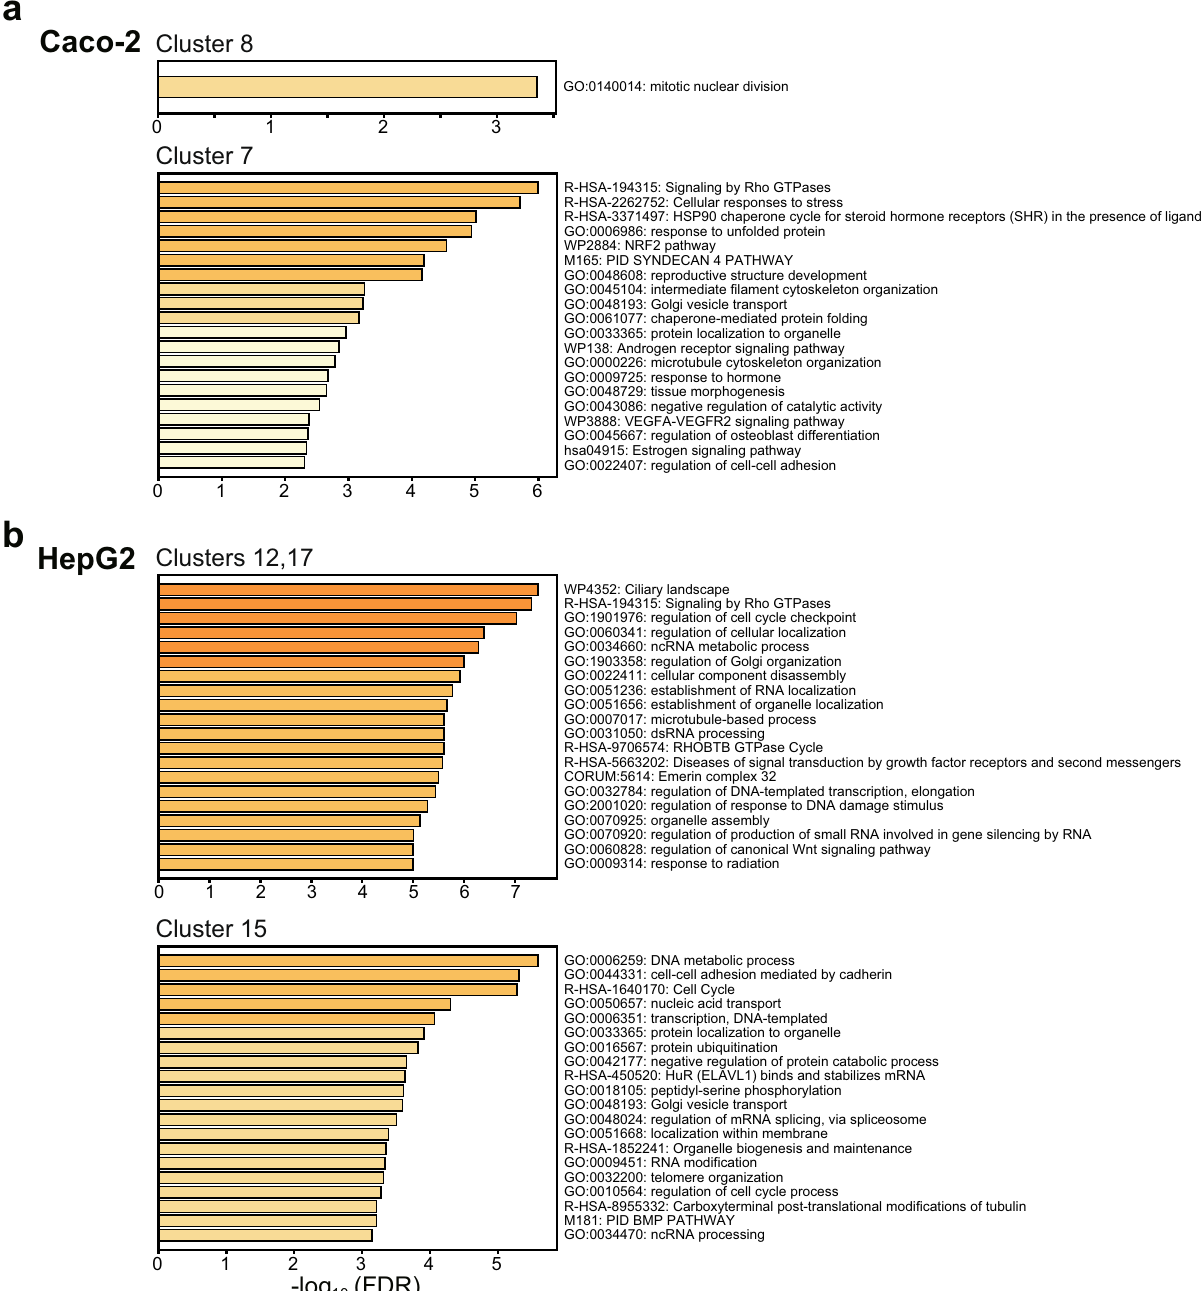
Fig. 7 Enriched gene ontology terms of the FFAs-treated Caco-2 and HepG2 cells under mono- and co-cultured conditions. a , b Bar graphs showing gene enrichment related to certain GO terms and pathways for representative K-means clusters of FFAs-treated Caco-2 and HepG2 cells under mono- and co- cultured conditions. The other clusters were shown in Supplementary Figs. S14 –